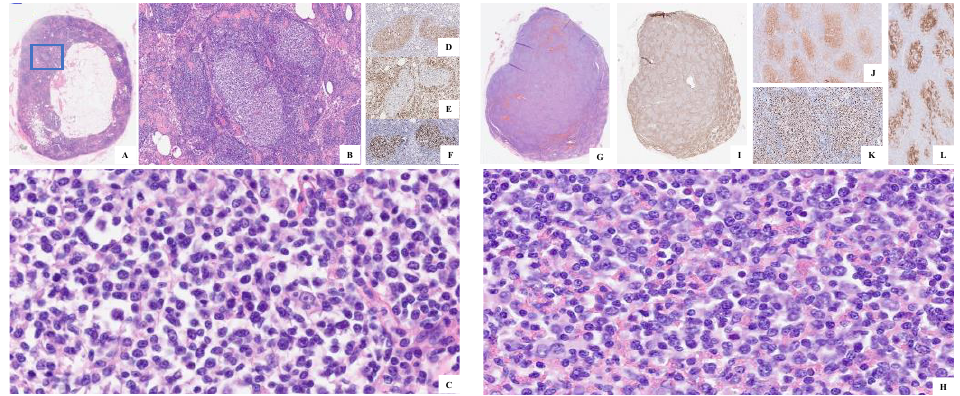
Figure 3. ( A ) H&E original magnification 2x of the right iliac-obturator lymph node displaying two atypical follicles highlighted in the blue rectangle. ( B ) H&E original magnification 10x of the atypical follicles. ( C ) H&E original magnification 40x of the atypical germinal centers with the absence of polarization and enrichment in centroblasts. ( D ) CD10+, ( E ) BCL2-, and ( F ) Ki67 immunostains. ( G ) H&E original magnification ×4 of the left iliac-obturator lymph node. ( H ) H&E original magnifica- tion 40x of the overt FL on the left iliac-obturator lymph node. ( I ) BCL2-. ( J ) CD10+. ( K ) Ki67. ( L